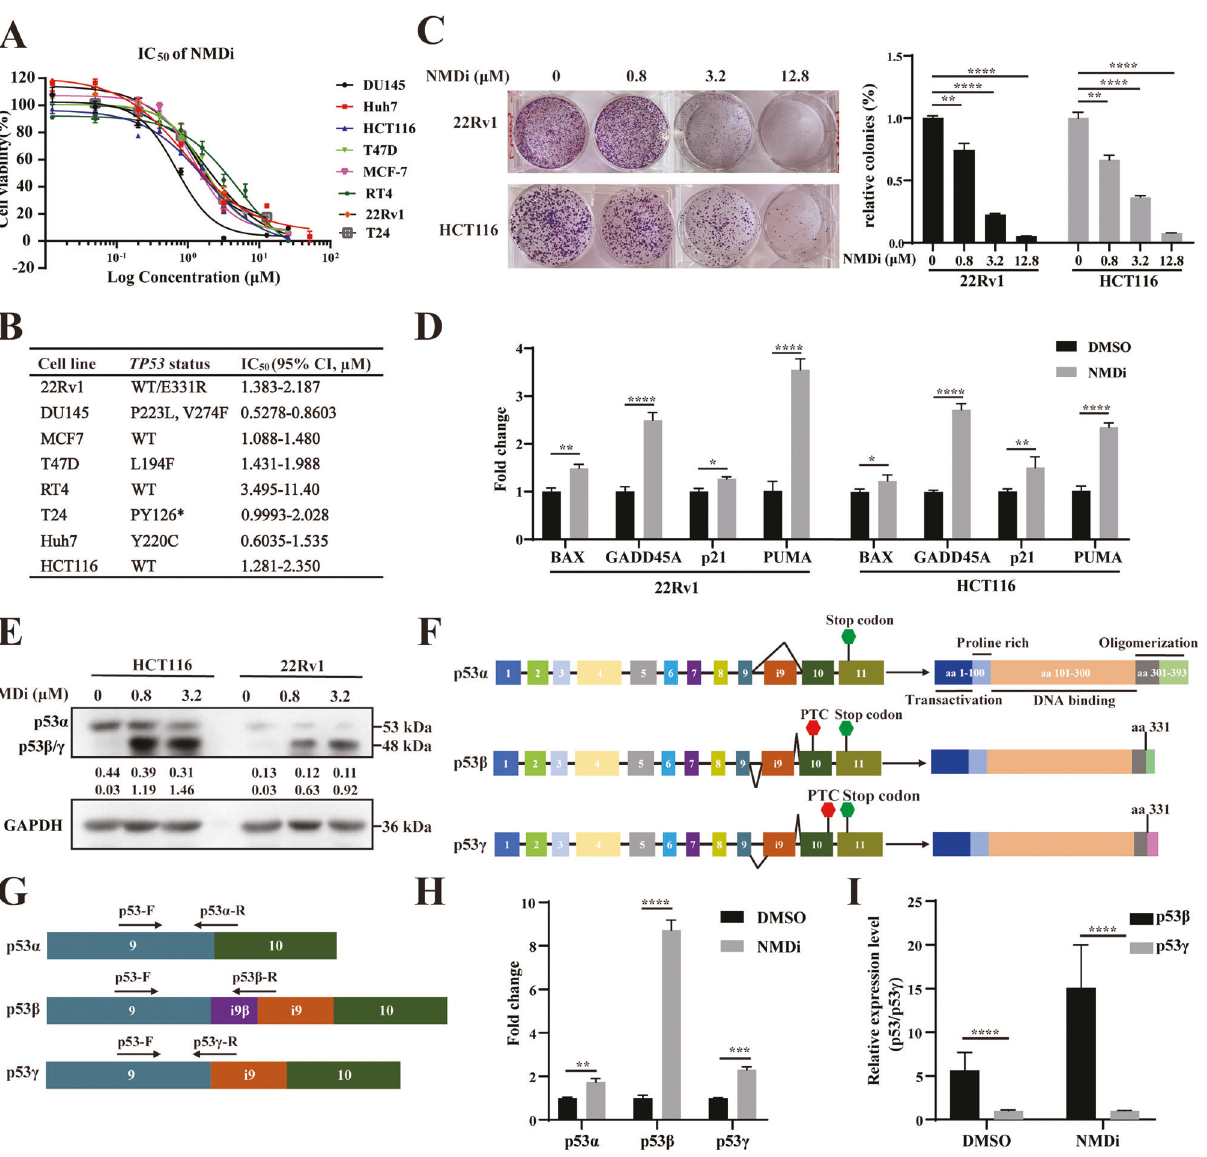
Fig. 1 NMDi as a potential anti-cancer agent via the p53 pathway. A Eight solid tumour cell lines were treated with different concentrations of NMDi for 72 h, and the cell viability was measured using CCK-8 assay. B IC 50 and TP53 status of eight cell lines. Asterisk represents a nonsense mutation. C Images and quantitative analysis of the colony-forming assay of 22Rv1 and HCT116 cells treated with the indicated concentrations of NMDi for 24 h and cultured for 14 days. D mRNA expression fold change of p53 target genes ( P21 , PUMA , BAX and GADD45A ) in 22Rv1 and HCT116 cells treated with 3.2 µM NMDi for 24 h using qPCR. E 22Rv1 and HCT116 cells treated with the indicated concentrations of NMDi introduced a band of p53 around 48 kDa using Western blot. F Schematic of three major isoforms of p53, i.e. p53 α , p53 β and p53 γ , resulting from alternative splicing of intron 9. The green stop sign represents a normal stop codon, and the red stop sign represents a PTC. G Design of isoform-speci fi c primers of the three p53 isoforms. These three isoforms share a common forward primer, and have speci fi c reverse primers that across the splicing site. H Fold change in the mRNA expression level of three p53 isoforms in 22Rv1 cells treated with DMSO or 3.2 µM NMDi for 24 h using qPCR. I Relative fold change of p53 β to p53 γ in 22Rv1 cells treated with DMSO or 3.2 µM NMDi for 24 h. (Data are mean ± standard deviation, and p -values were calculated by ungrouped t -test. * p ≤ 0.05, ** p ≤ 0.01, *** p ≤ 0.001, **** p ≤ 0.0001 vs. control group; ns not signi fi cant. N = 3). Combination treatment of XR-2 and NMDi synergistically (Fig. S2D). β -galactosidase staining assay was conducted to further induces cell apoptosis and activates the p53 pathway in TP53 evaluate cell senescence. 22Rv1 and HCT116 cells treated with XR- wild-type cancer cells 2 or NMDi for 96 h had an increase in the proportion of β -galactosidase-positive cells, and combined treatment with these Further, Western blot was performed to study protein expression of apoptosis markers and p53 isoforms (p53 α and p53 β ) following two agents led to a synergistic upregulation of β -galactosidase- combination treatment. As shown in Fig. 4A, B, 22Rv1 and HCT116 positive cells (Fig. 2G, H). Altogether, these data suggest the cells treated with NMDi or XR-2 for 24 h slightly or barely increased synergistic effects of combined treatment with NMDi and XR-2 on the expression of cell apoptosis biomarkers. When the cells were TP53 wild-type cancer cells were due to increased cell apoptosis treated with a combination of NMDi and XR-2, a dramatically and senescence, and cell-cycle arrest.